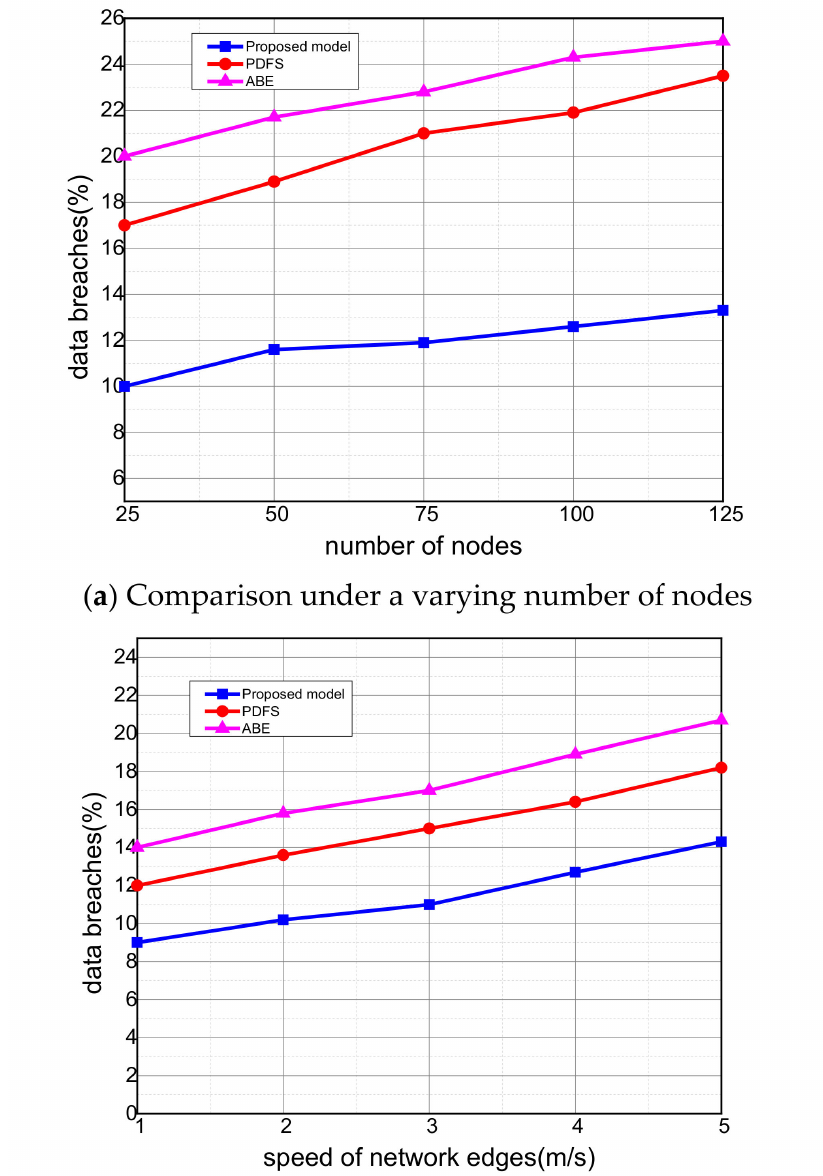
Figure 7. Evaluation of data breaches among proposed model, PDFS,